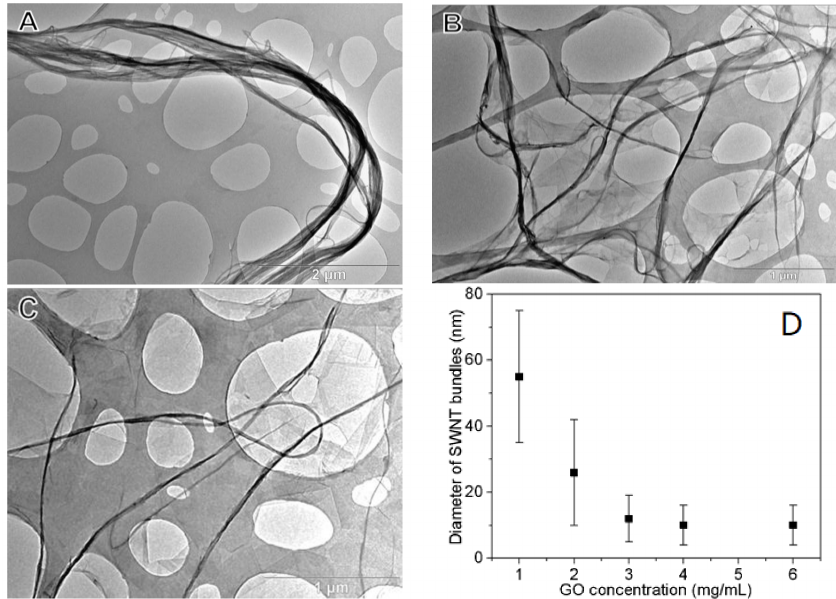
Figure 2. TEM micrographs of ( A ) SWNT bundles in water; ( B ) GO-SWNT dispersion with a GO:SWNT mass ratio of 10:1; ( C ) GO-SWNT dispersion with a GO:SWNT mass ratio of 20:1. The concentration of SWNT in each case is 0.2 mg/mL; ( D ) Effect of GO concentration on the diameter of SWNT bundles in the dispersion. The SWNT content in the ink is 0.2